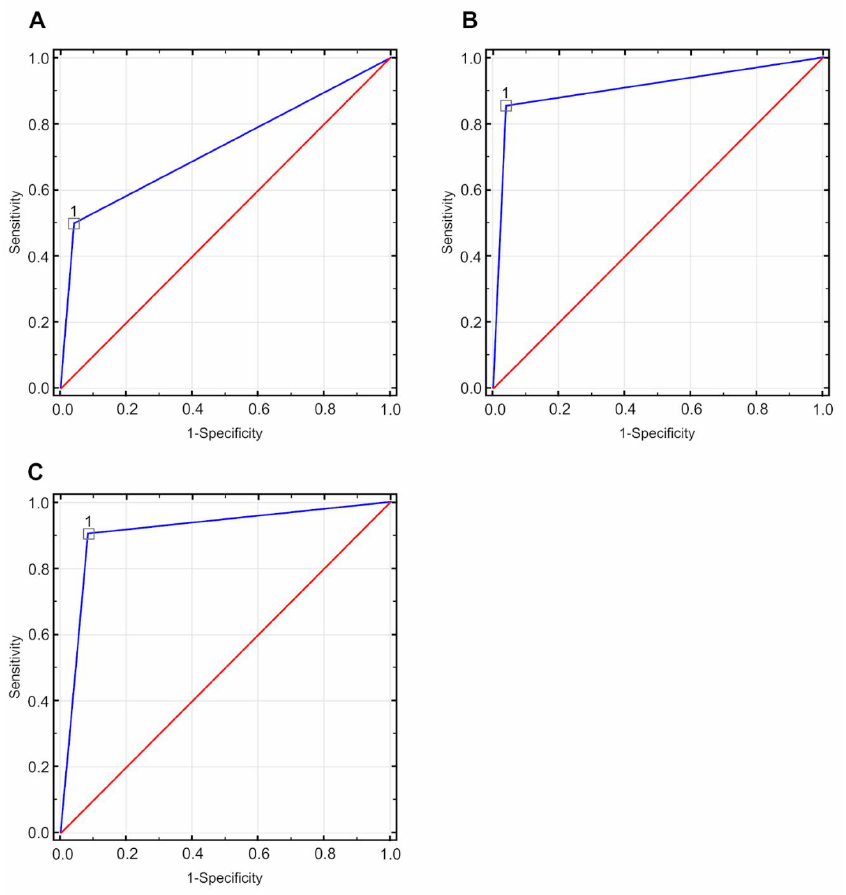
Figure 5. Receiver operating characteristic (ROC) curves based on the tested diagnostic methods (directional coefficient = 1.00, suggested cut-off point = 1.00): ( A ) for the mammography (MG) method, the value of the area under the curve (AUC)